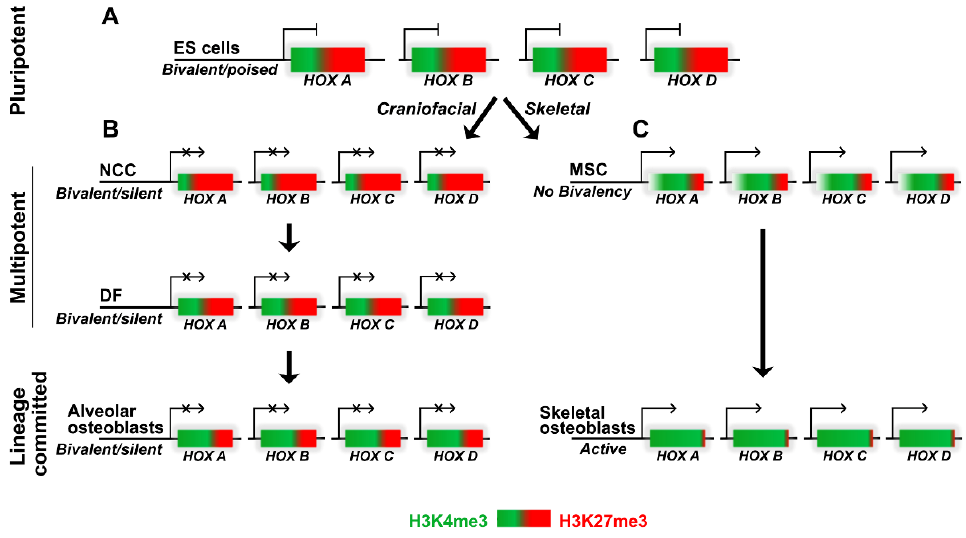
Figure 7. HOX gene transcriptional regulation by histone modifications. ( A ) HOX promoters ( HOX A, HOX B, HOX C, and HOX D) in embryonic stem (ES) cells are transcriptionally poised and feature bivalent chromatin comprising H3K4me3 (green) and H3K27me3 (red) histone modifications. ( B ) Craniofacial lineage progenitors, neural crest cells (NCC), dental follicle (DF), and alveolar osteoblasts do not express HOX genes and exhibit varying levels of bivalency. ( C ) HOX promoter bivalency is lost in the skeletal lineage mesenchymal stem cells (MSCs) and in lineage-committed skeletal osteoblasts, leading to high levels of HOX gene expression.